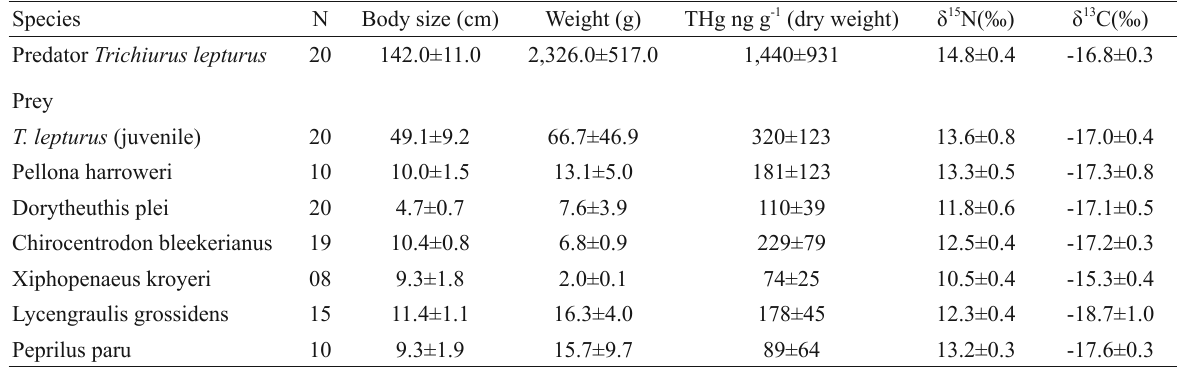
Body dimensions, total mercury concentration (THg), and isotopic ratios ( δ 15 N and δ 13 C) of Trichiurus lepturus (adult specimens) and its preferred